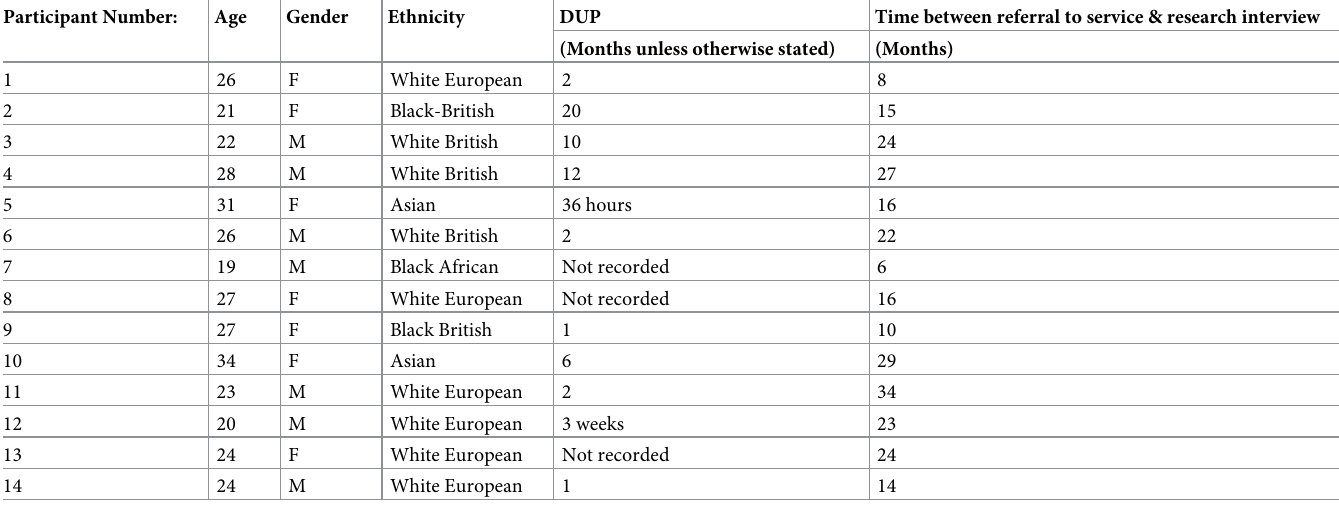
Table 1. Characteristics of